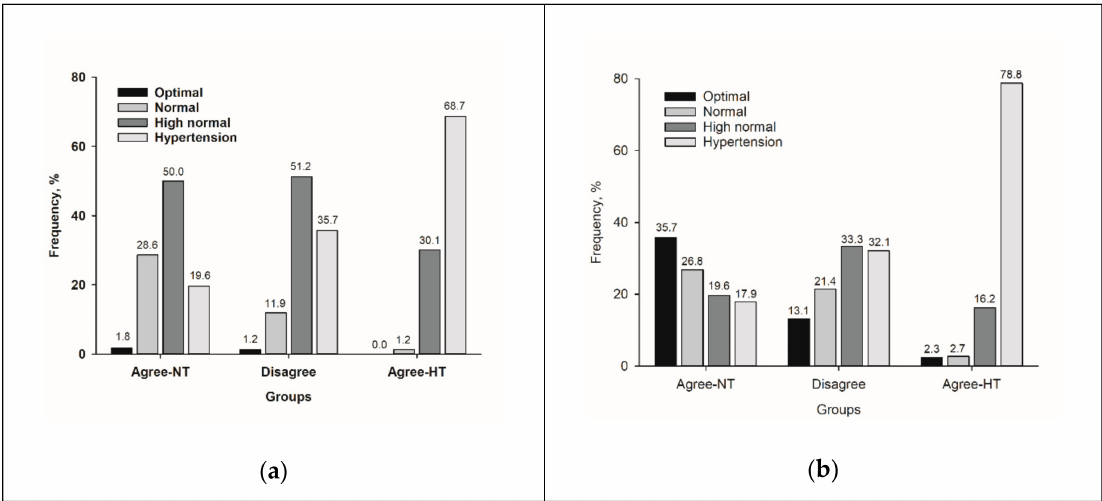
Figure 2. Distributions of o ffi ce ( a ) systolic and ( b ) diastolic BP classification. Abbreviations: BP, blood pressure; Agree-NT, home and daytime ambulatory normotension; Disagree, home normotension and daytime ambulatory hypertension, or home hypertension and daytime ambulatory normotension; Agree-HT, home and daytime ambulatory hypertension.